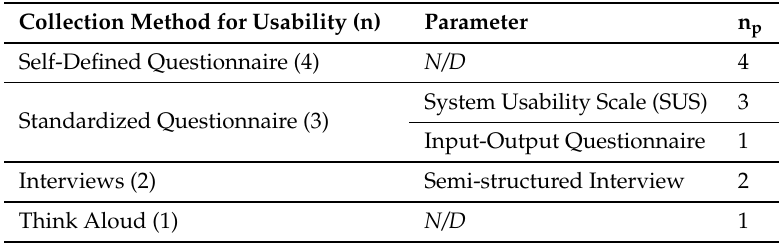
Table 15. Usability collection methods and parameters.